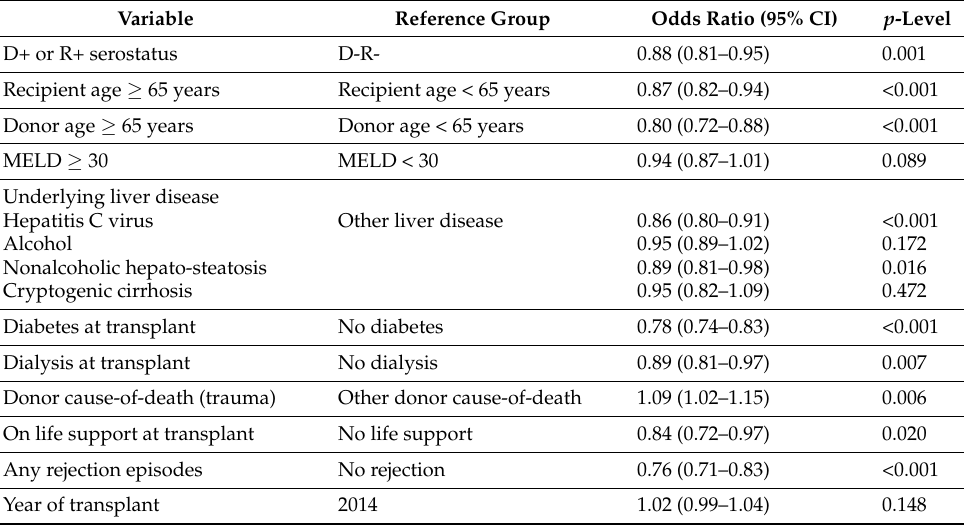
Table 4. Factors associated with normal functional status 1 at last follow-up.